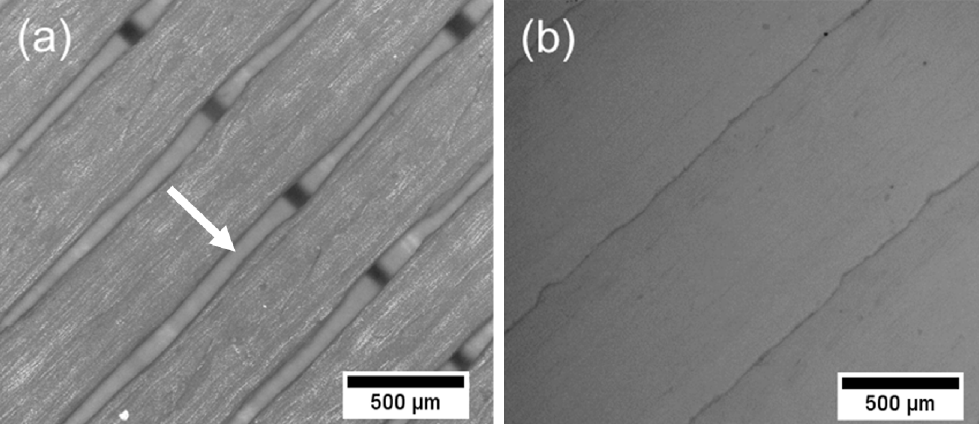
Figure 4. Optical micrograph showing the density of 3D printed samples using ( a ) 0.5 mm extrusion width versus ( b ) 0.45 mm extrusion width.